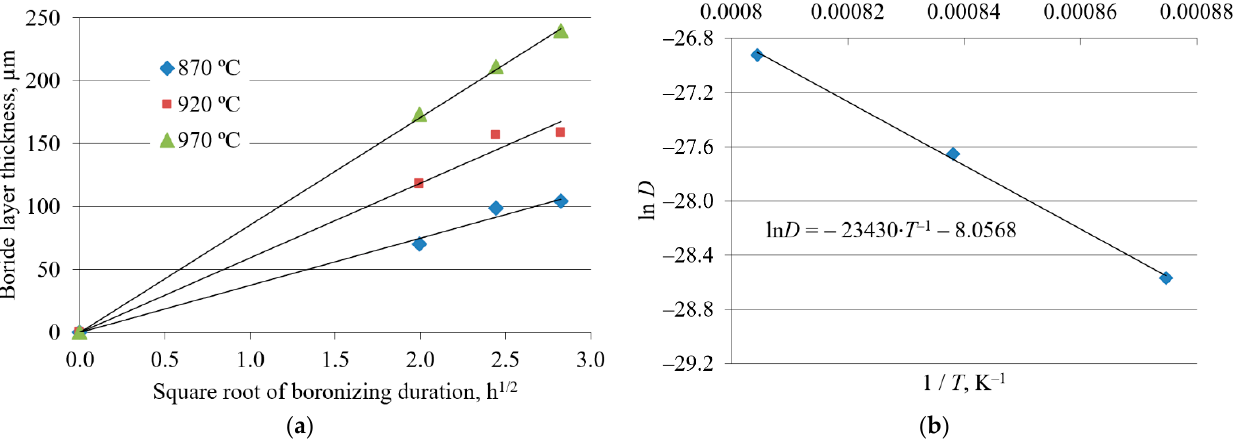
Figure 5. Growth kinetics of boride layers on C15 steel: ( a ) Boride layer thickness as a function of the square root of the boronizing duration; ( b ) natural logarithm of growth rate constant as a function of the reciprocal boronizing temperature [43]. Reprinted with permission from ref. [43]. Copyright 2012 Mechanical Engineering Faculty in Slavonski Brod.